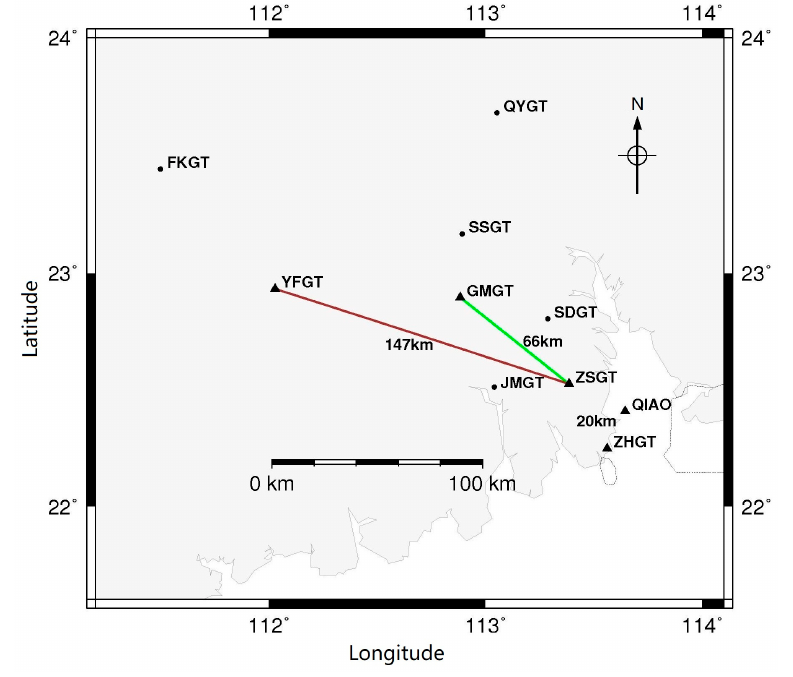
Figure 1. Distribution of the used stations in GDCORS and the selected baselines. Table 4. The selected optimal and suboptimal combinations for three baselines in this experiment.